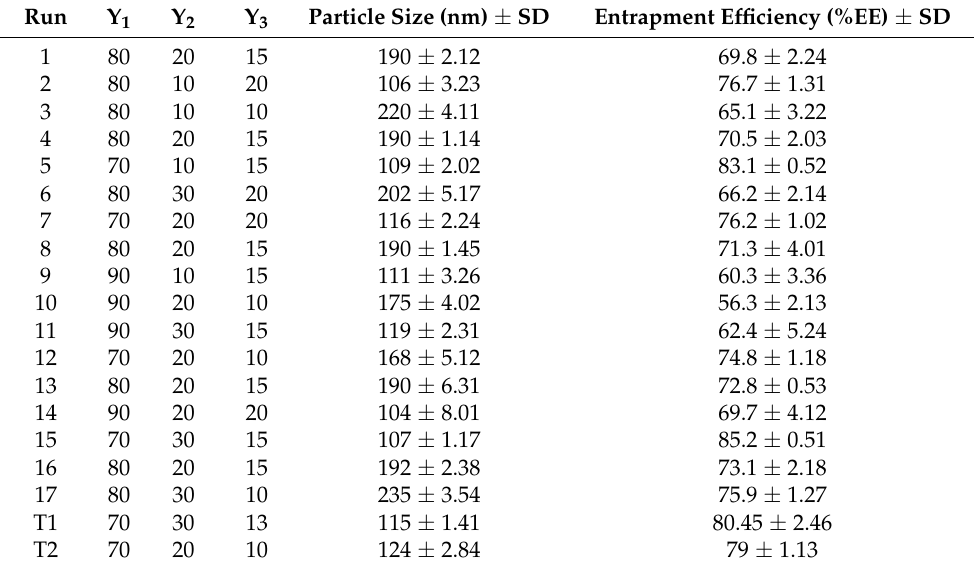
Table 2. Effect of independent variable on various responses expressed as mean ± SD (n = 3).